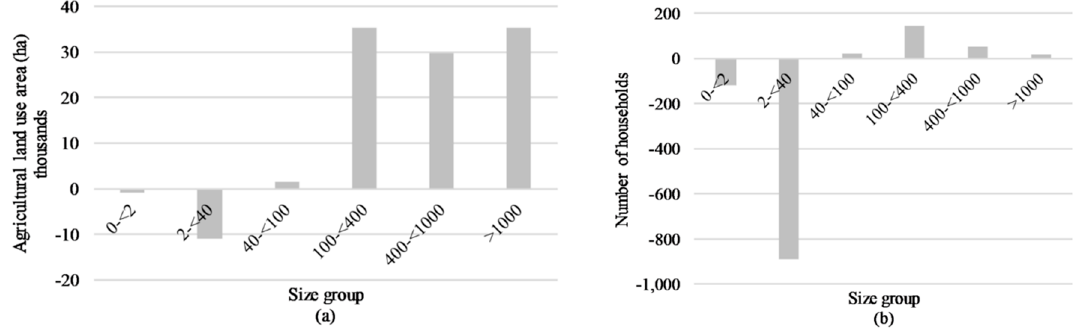
Figure 8. ( a ) Difference in the area (ha) of agricultural land use, ( b ) Difference in the number of agricultural households in size groups between 2011 and 2016 (ARIB).